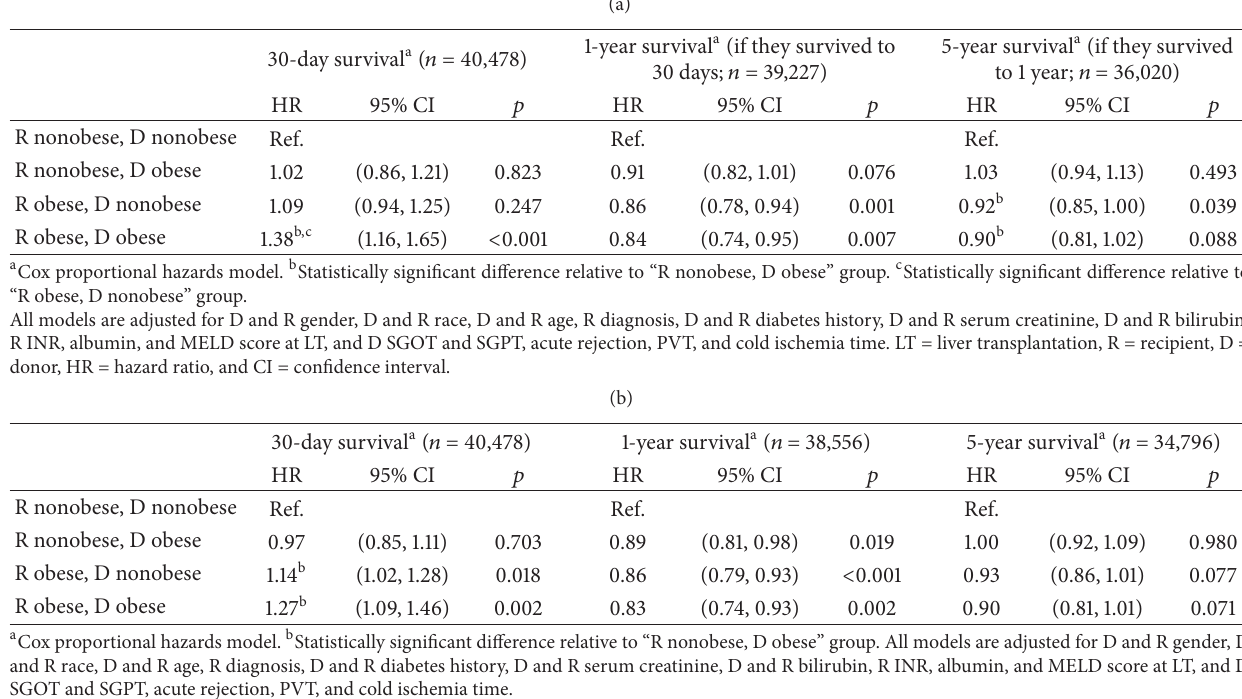
Table3:(a)Multivariableregressionmodelsofpatientsurvivalafterlivertransplantation.(b)Multivariableregressionmodelsofgraftsurvival after liver transplantation. (c) Multivariable regression models of primary and secondary outcomes after liver transplantation.